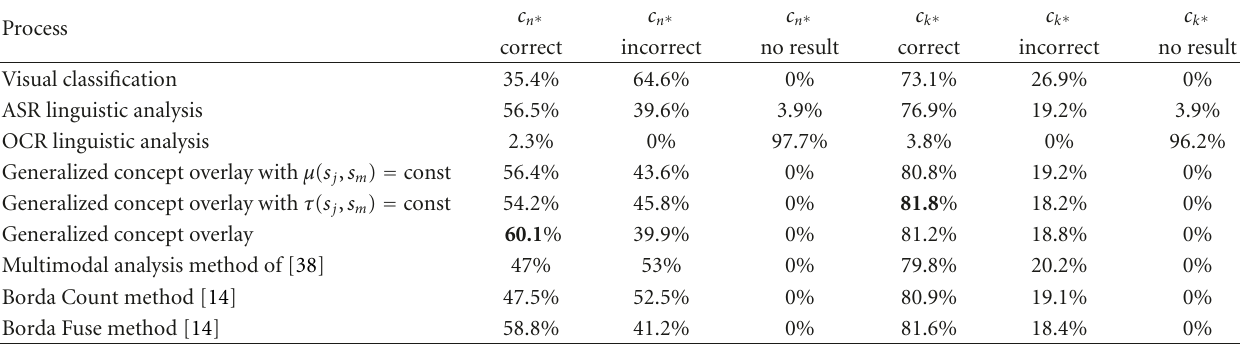
Table 3: Multimodal analysis results in the news domain—dataset restricted to shots for which more than one single modality analysis results